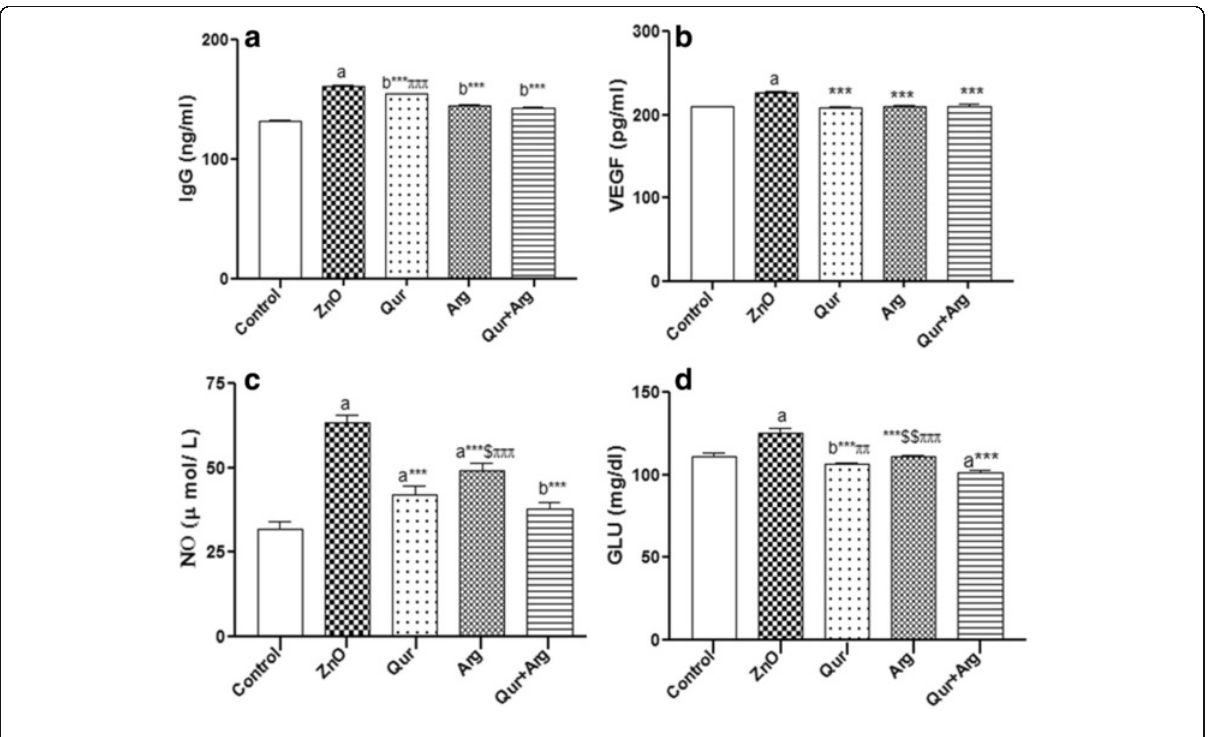
Figure 1 Effect of Qur and/or Arg treatment on serum IgG (a), VEGF (b), total nitrate/nitrite (c), and glucose (d) concentrations in intoxicated rats with low dose of n-ZnO particles. Values are expressed as mean±S . D. a P < 0.001, b P < 0.01 compared with the normal control group, *** P < 0.001 compared with the n-ZnO-intoxicated group, $$ P ≤ 0.01, $ P ≤ 0.05 compared with the Qur-treated group, πππ P ≤ 0.001, ππ P ≤ 0.01 compared with the combination group, respectively, using ANOVA followed by Bonferroni as a post-ANOVA